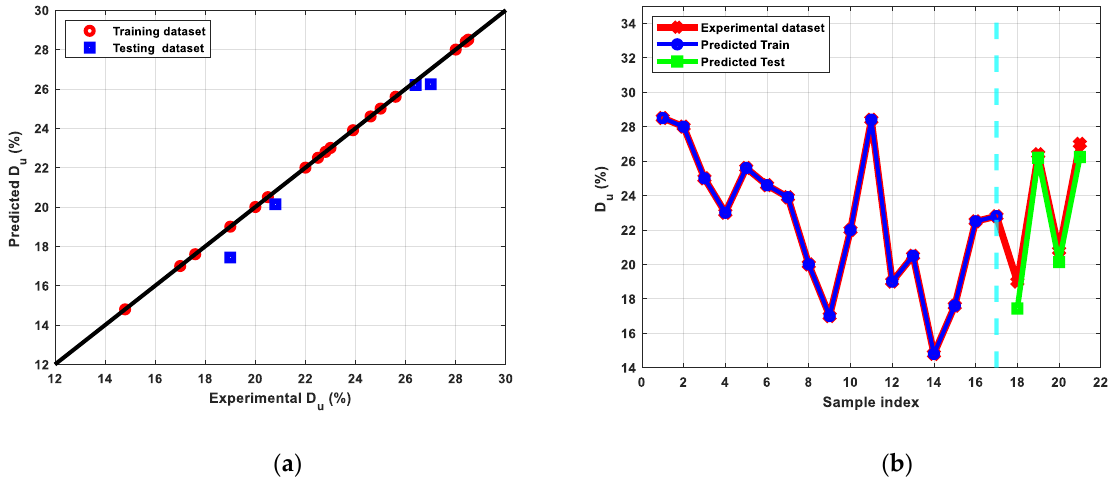
Figure 12. ( a ) Predicted versus experimental D u evaluated for the training and the testing sets,